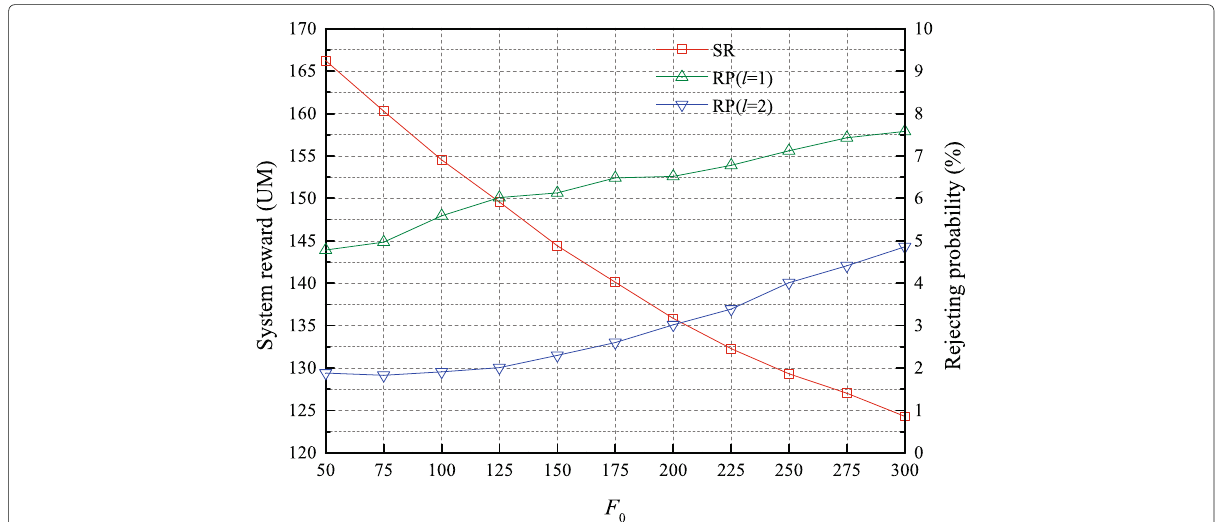
Fig. 14 SR and RPs under different F 0 . This figure shows the impacts of the penalty coefficient ( F 0 ) on the evaluation